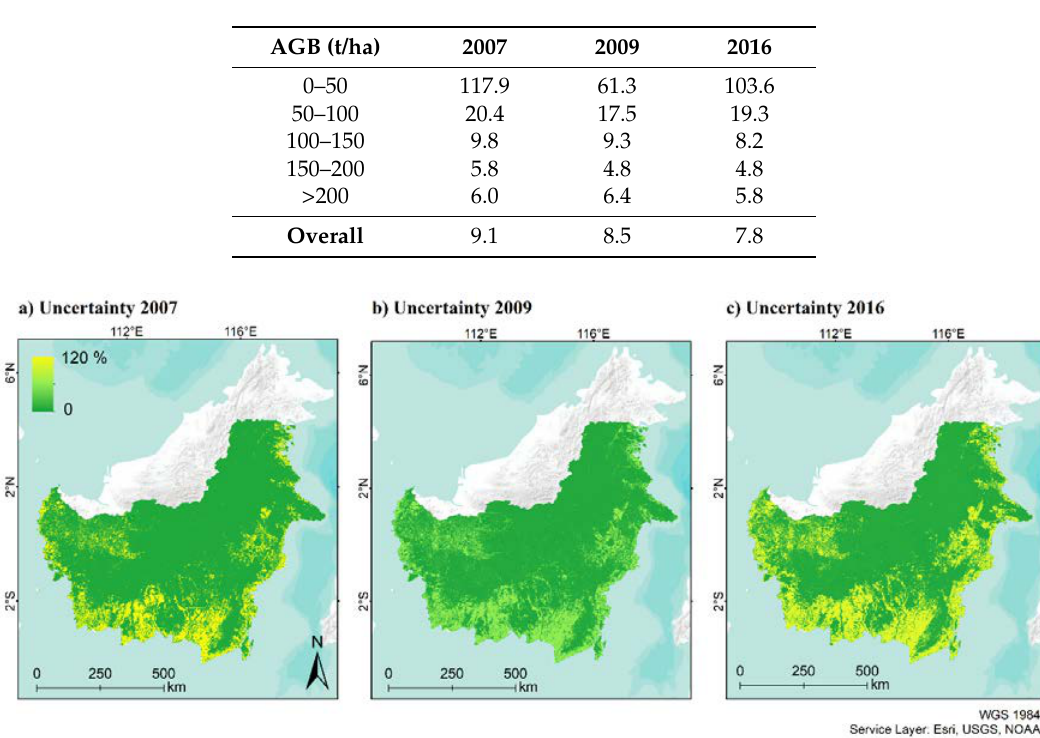
Table 4. Uncertainty per AGB range and year in percentage.